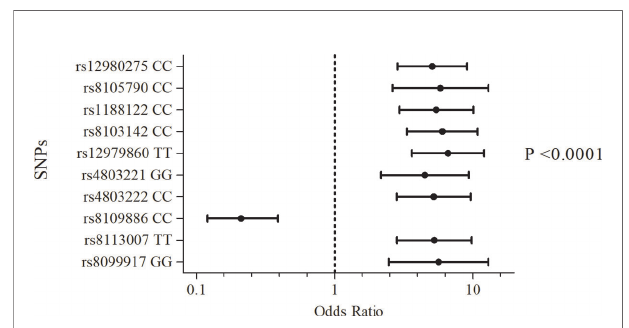
FIGURE 1 | Association of the SNPs of the IFNL3/IFNL4 region with the outcome of Peg-IFN- a /RBV treatment. Logistic regression models included viral genotype, ethnicity, fi brosis, baseline viral load, and type of treatment as categorical covariates. P-values were adjusted